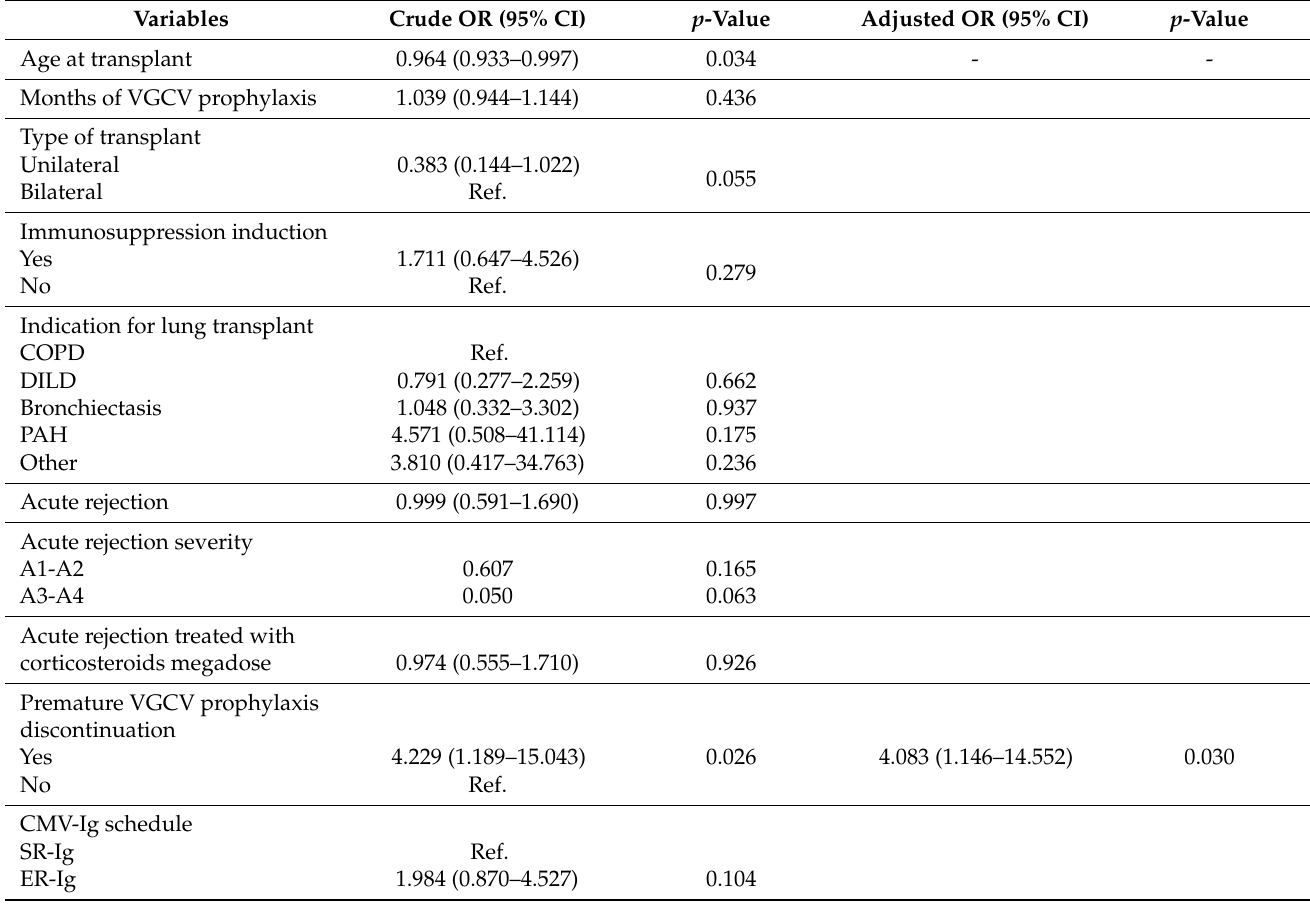
Table 3. Risk factors for first CMV infection using logistic